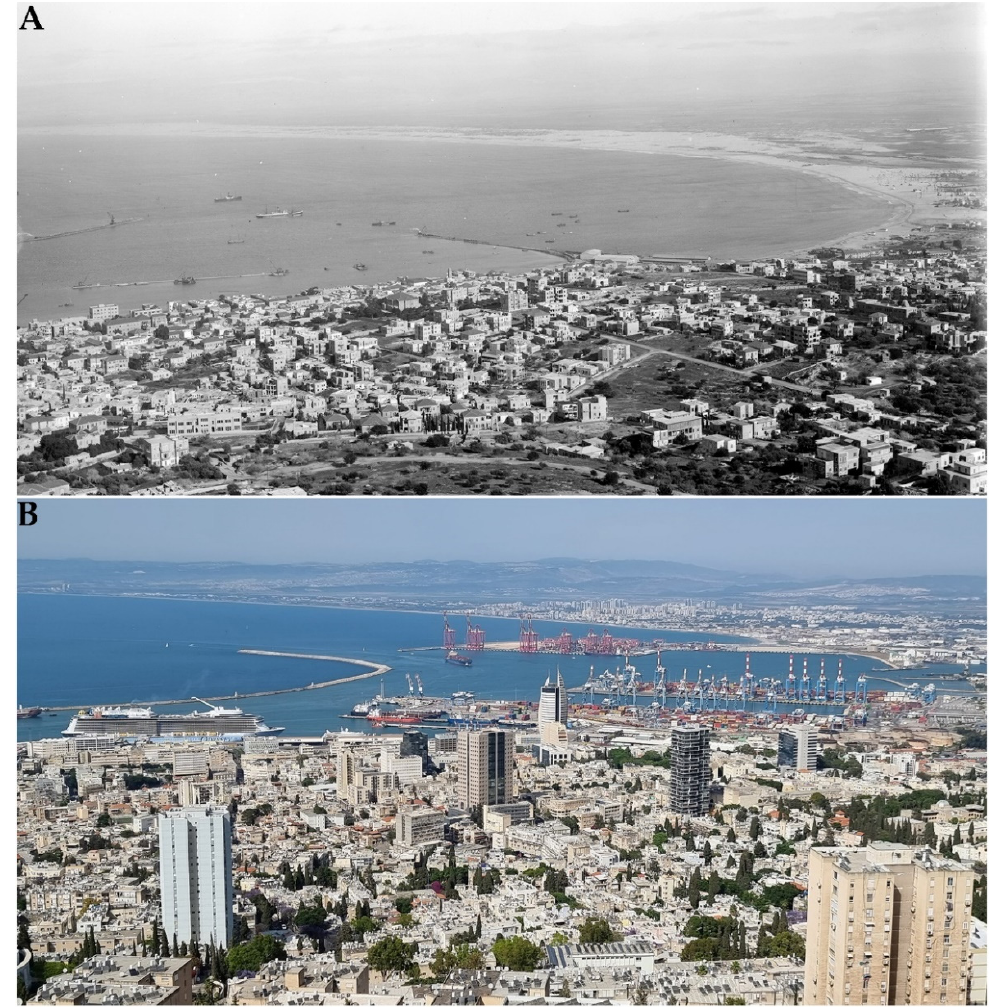
Figure 11. Haifa Port under construction during the British Mandate in 1931 ( A ) (Library of Congress Prints and Photographs Division Washington, D.C. 20540 USA) (matpc 08935 hdl.loc.gov/loc.pnp/matpc.08935 accessed on 27 September 2022) and the Haifa Port area in 2022 ( B ) (photograph by Dov Zviely 5.28.2022).